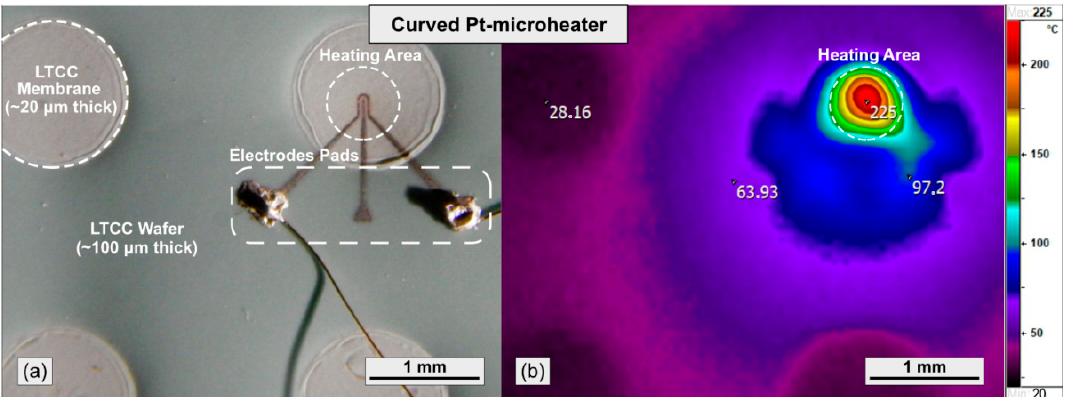
Figure 12. ( a ) Photo and ( b ) thermogram of curved Pt-microheater printed on a 20 µ m thick low-temperature co-fired